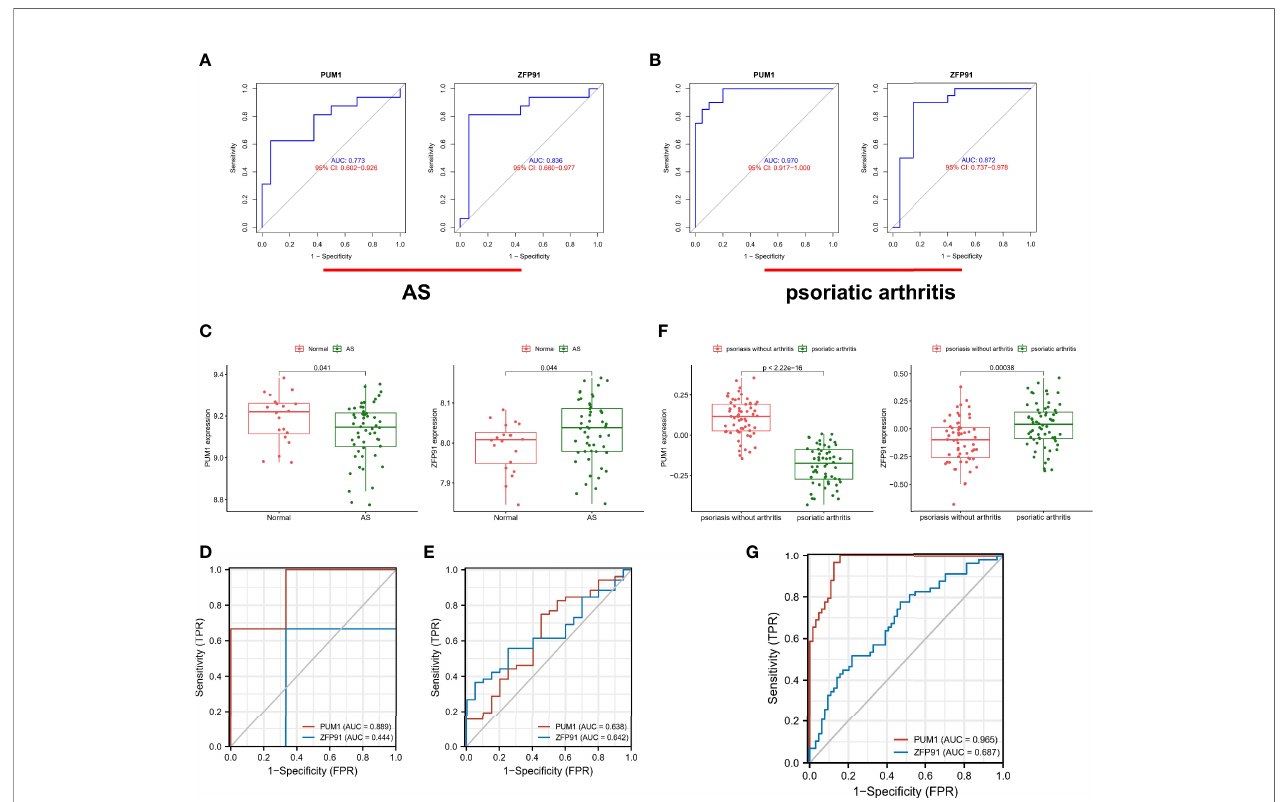
FIGURE 6 | Validation of diagnostic shared biomarkers. (A) The ROC curve of the diagnostic ef fi cacy veri fi cation in GSE25101. (B) The ROC curve of the diagnostic ef fi cacy veri fi cation in GSE61281. (C) The shared biomarkers in GSE73754 showed signi fi cant differences, with p value < 0.05. (D) The ROC curve of the diagnostic ef fi cacy veri fi cation in data of samples from our hospital. (E) The ROC curve of the diagnostic ef fi cacy veri fi cation in GSE73754. (F) The shared biomarkers in GSE13355 showed signi fi cant differences, with p value < 0.05. (G) The ROC curve of the diagnostic ef fi cacy veri fi cation in